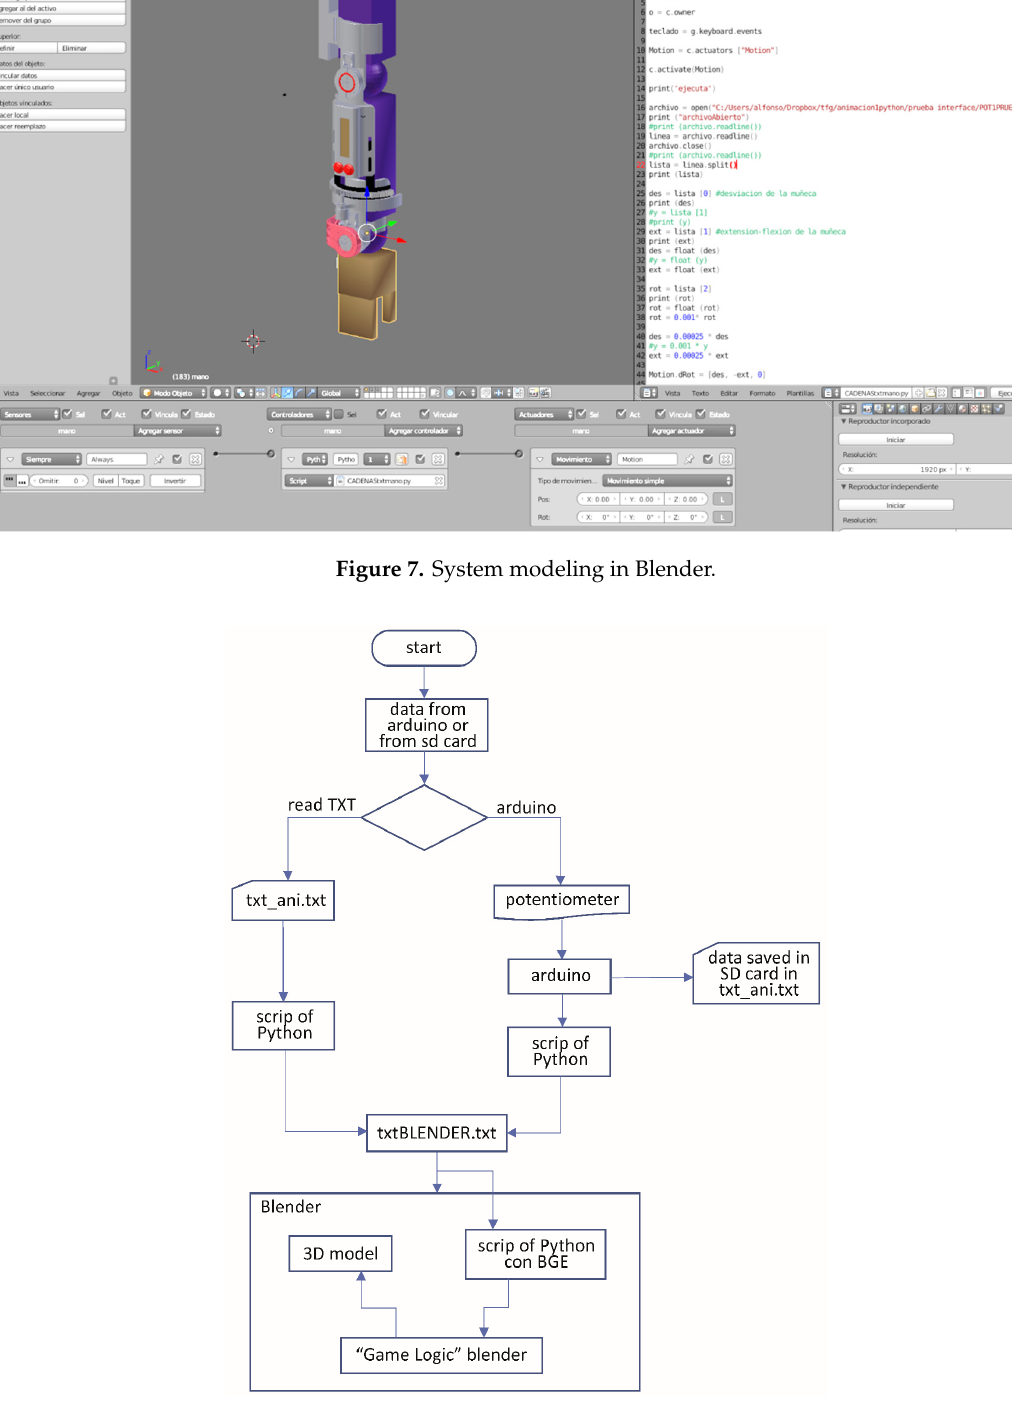
Figure 8. 3D animation data flowchart.